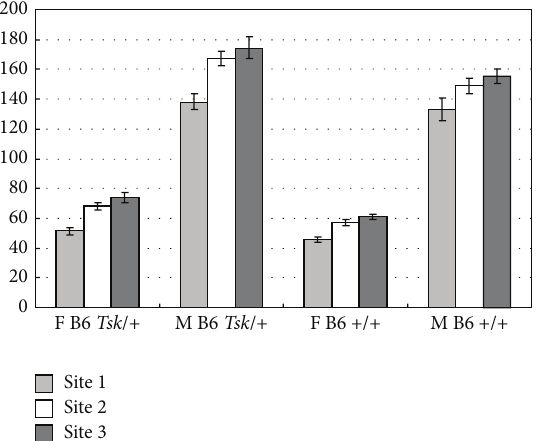
Figure 1: Hydroxyproline content of 4mm skin punches from B6 Tsk /+ and B6 +/+ mice . Site 1: proximal (light grey bar); Site 2: middle (white bar); Site 3: distal dorsum (dark grey bar). F: females and M: males. Hydroxyproline values are expressed as 𝜇 g/4mm skin punch. The standard error of the mean is